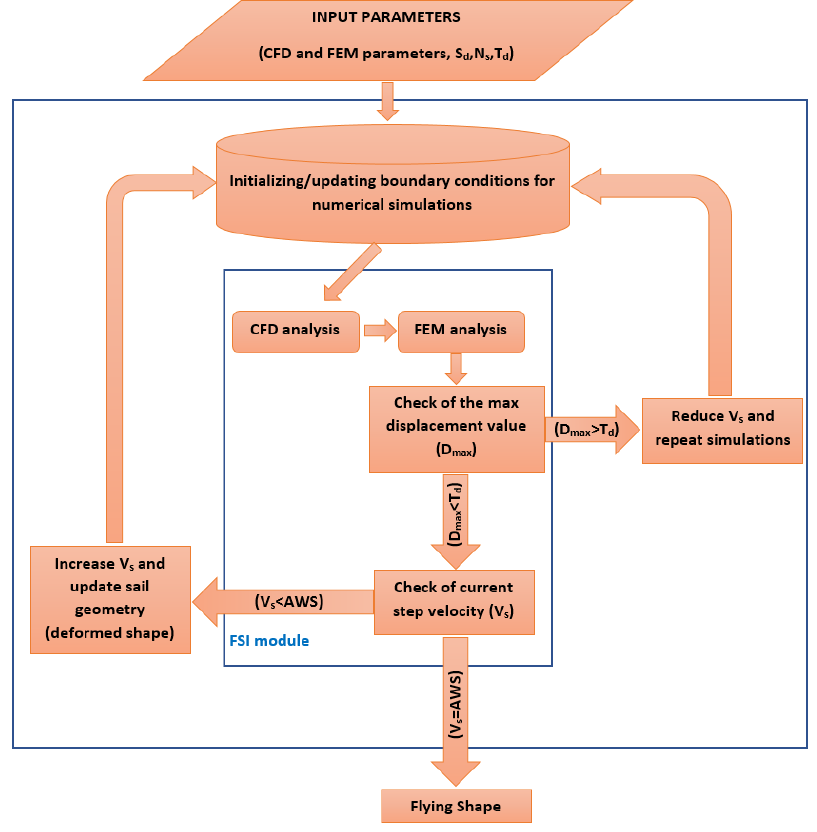
Figure 13. Flow chart of the developed fluid – structure interaction (FSI)